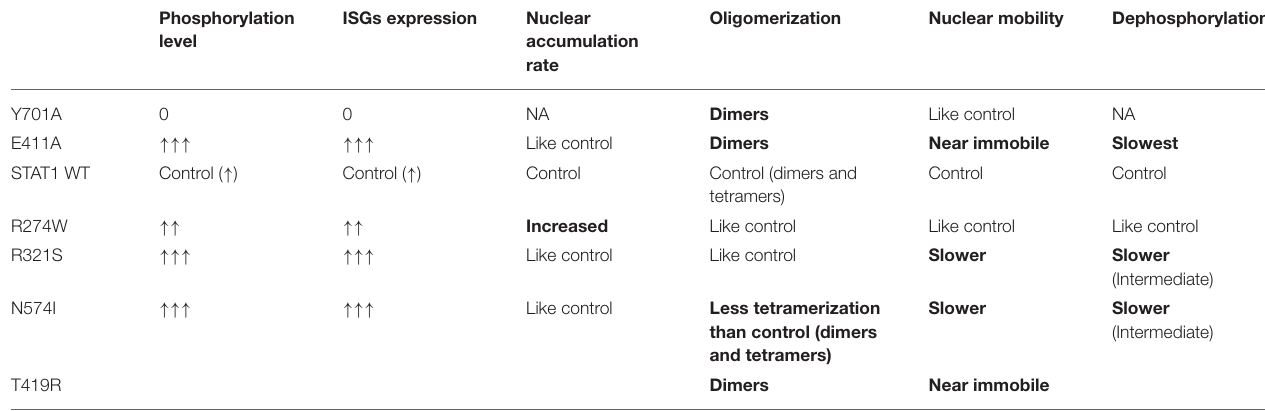
TABLE 1 | Schematic summary of the molecular phenotypes observed for the different STAT1 mutants and controls analyzed in this